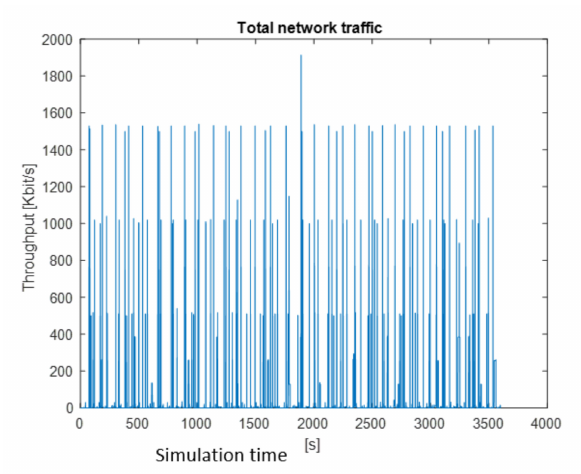
Figure 10. Total traffic generate by Node 1.